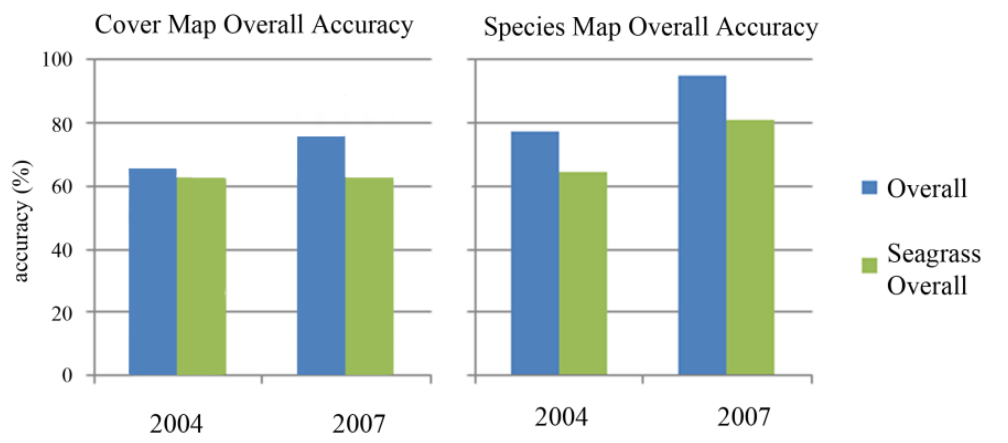
Figure 6. Accuracy values for the 2004 and 2007 seagrass cover (left) and seagrass species (right) maps. ―Overall‖ accuracy includes all mapping classes and ―Seagrass Overall‖ includes only the seagrass mapping categories ( i.e. , excluding sand and deep water).